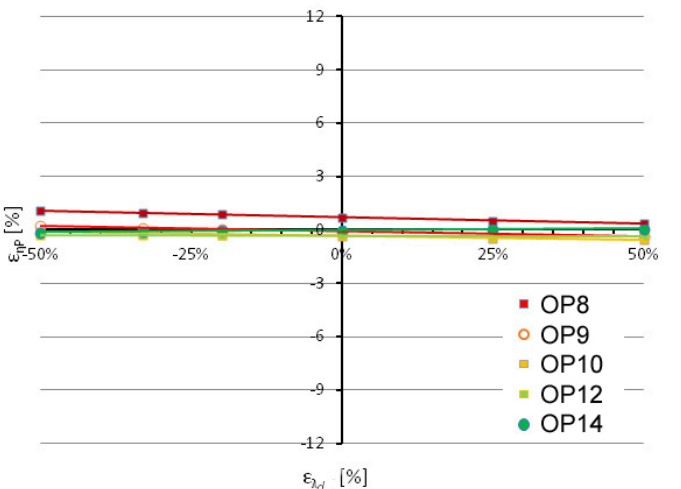
Figure 15. Algorithm sensitivity analysis regarding the determination of the pump efficiency (cid:101) η for deviations in the input of the longitudinal losses coefficient for the discharge line (cid:101) λ operating points: OP8, OP9, OP10, OP12 and OP14.